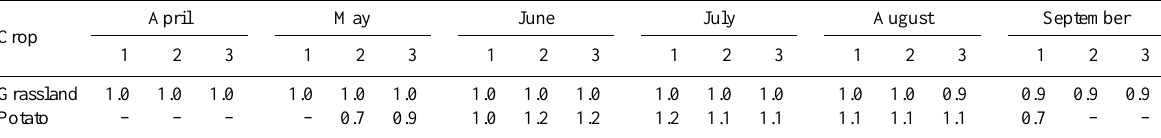
Table B1. Crop coefficients for grassland and potato, per ten-day interval of the growing season as given by Feddes (1987). These K c,tot coefficients are for the “all-in-one” transpiration, canopy interception evaporation and soil evaporation models.